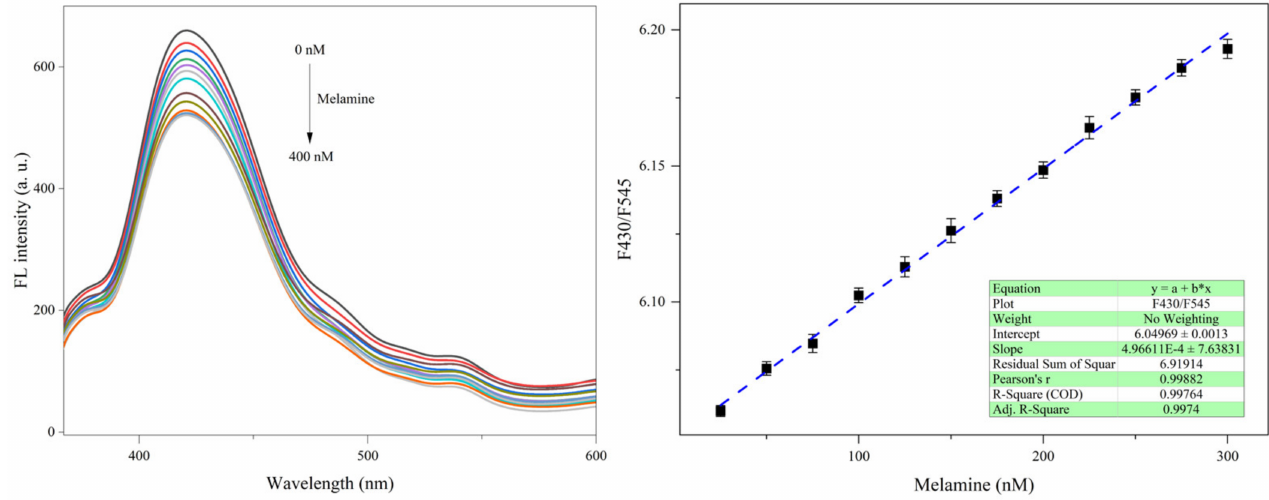
Figure 6. Fluorescence emission spectra of Tb@NH 2 -MIL-253 (Al) MOF sensing platform in the presence of different concentrations of